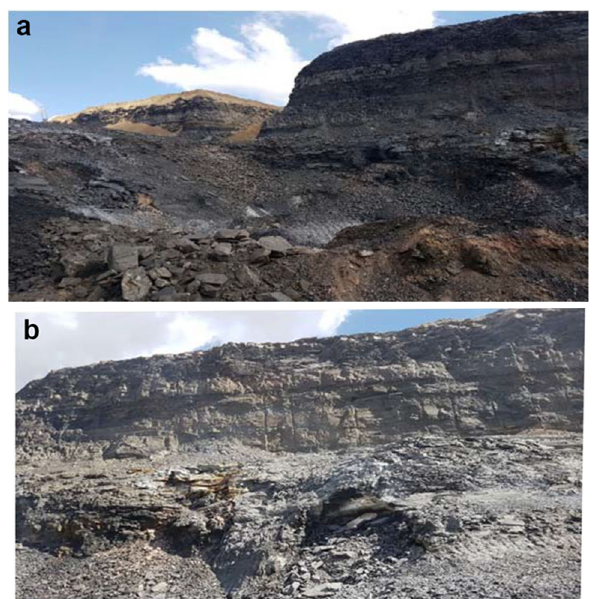
Fig. 1 a Spontaneous combustion of highwall and b effects of shale spontaneous combustion at at Khwezela Mine (Bokgoni Pit), Witbank, South Africa